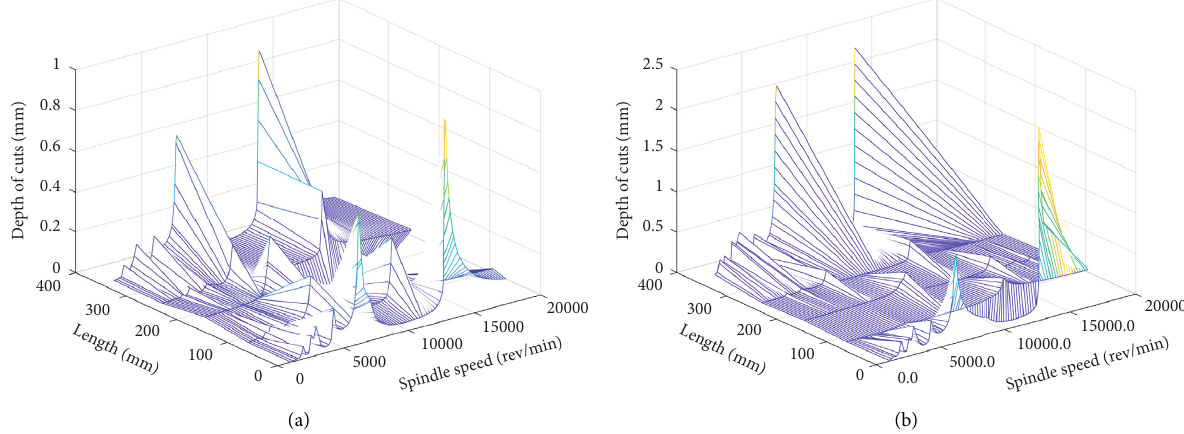
Figure 11: Predicted 3D SLDs for P1–P5 and P6–P10. (a) Predicted 3D SLD for P1–P5. (b) Predicted 3D SLD for P6–P10.